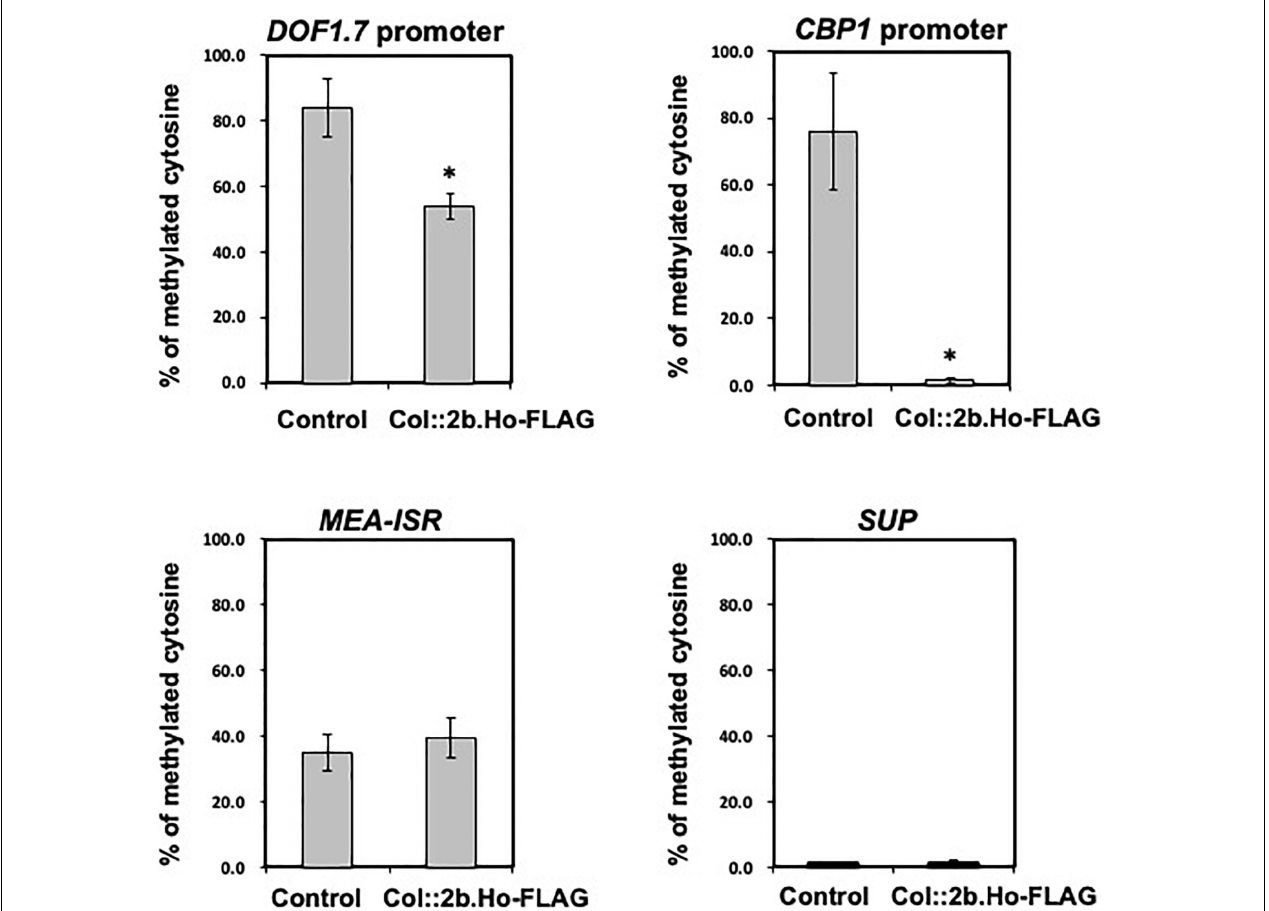
FIGURE 12 | Levels of hypomethylated cytosine in the promoter regions of two genes encoding the transcriptional regulators DOF1.7 and CBP1 by bisulfite sequencing analysis in CMV(Ho)tr- and mock-inoculated leaves of A. thaliana ecotype Col-0. Percentages of methylated cytosine of CG, CHG, and CHH in the promoter regions of DOF1.7 and CBP1 in three independent CMV(Ho) 2b -transformed Col-0 (Col:35Spro.2b.Ho-FLAG) and vector-transformed (control) Col-0 plants are shown in the bar chart with error bars ( n = 3, SD). As a control, the percentages of methylated cytosine of those transformants in the genomic regions of MEA-ISR , which is constitutively hypermethylated, and SUP , which is constitutively hypomethylated, are also shown by a bar chart with error bars ( n = 3, SD). Asterisks denote significant differences between Col:2b.Ho-FLAG and control (Welch’s t -test, p <